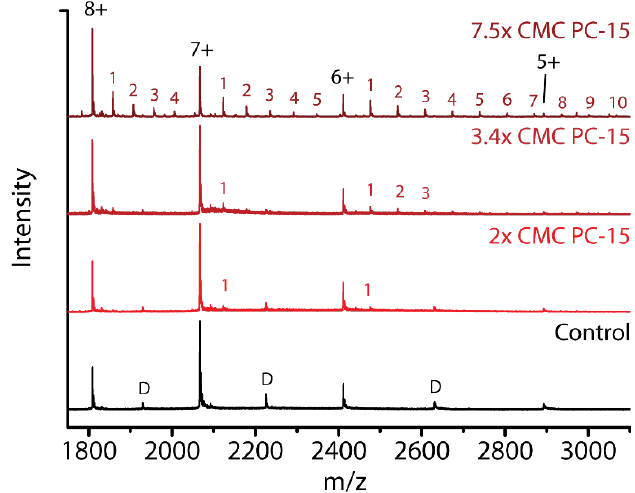
Figure 6. Mass spectra of the lower charge states when no detergent is present (Control) and when di ff erent concentrations of PC-15 are present (2 × CMC, 3.4 × CMC and 7.5 × CMC). A significant increase in number of PC-15 molecules bound is detected when increasing the concentration from 3.4 × CMC to 7.5 × CMC. Dimer peaks are indicated with a ‘D’.